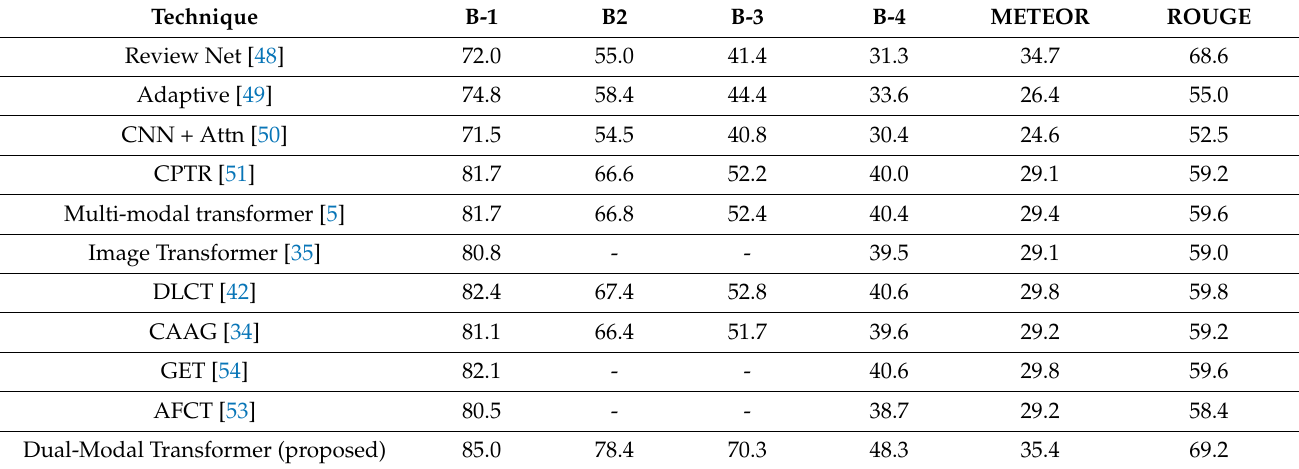
Table 7. A comparison of the proposed method with related state-of-the-art